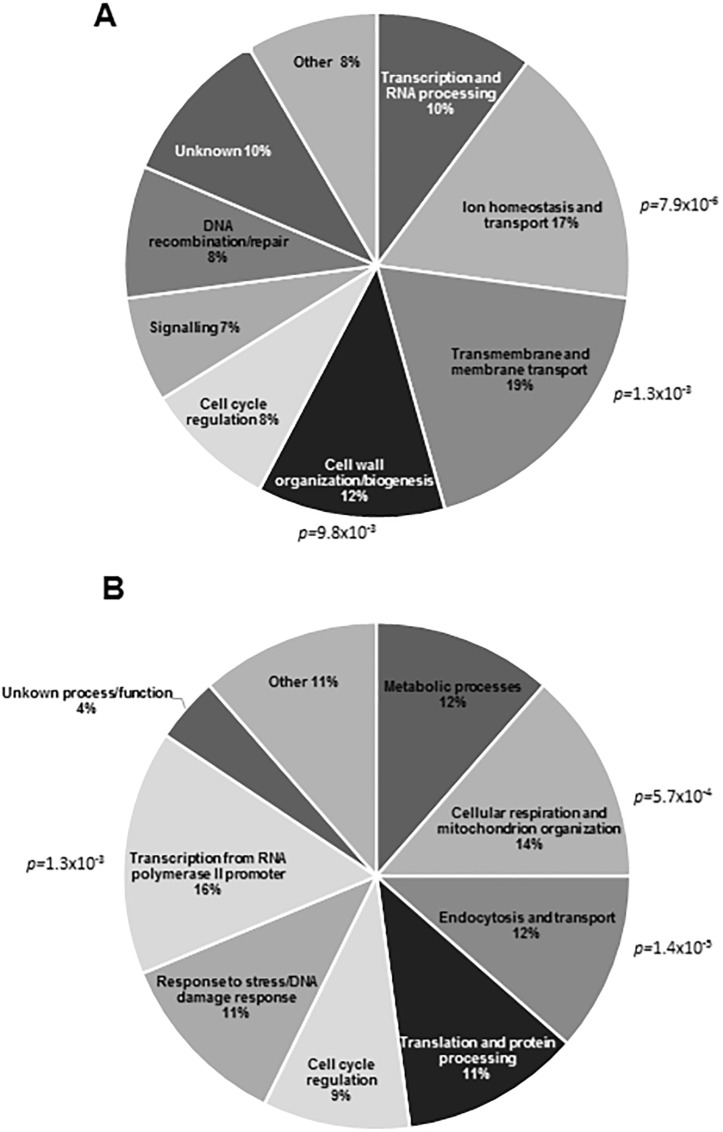
Functional distribution of deletion mutants that are highly sensitive to ZnONPs and AgNPs.(A) Clustering of the 59 most sensitive deletion mutant strains to 1 mg/mL ZnONPs reveal that mutants lacking genes involved in membrane and transmembrane transport, ion homeostasis and transport, and cell organization of biogenesis encompass the significantly enriched groups. (B) Clustering of the 96 most sensitive deletion mutant strains to 0.095 mg/mL AgNPs indicate that mutants lacking genes involved in transcription, cellular respiration, and endocytosis and vesicular transport represent the significantly enriched groups.